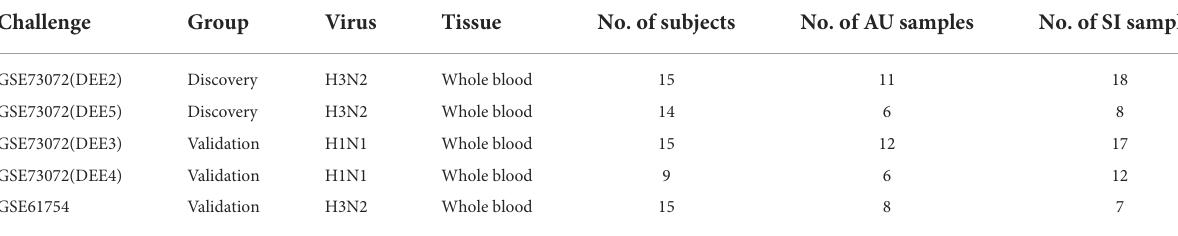
TABLE 1 Characteristics of included influenza challenge cohorts taken as baseline.